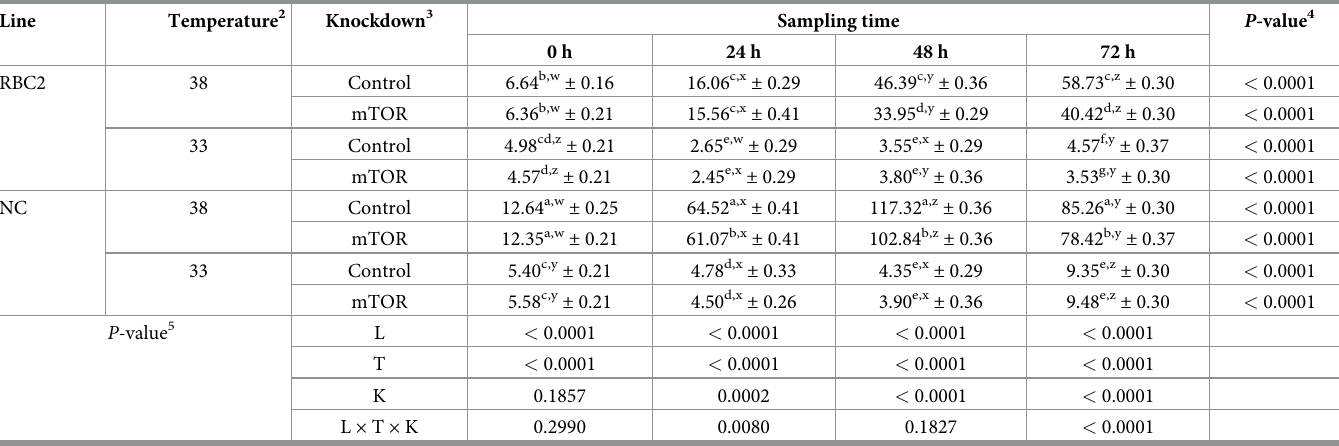
Table 7. Effect of cold stress (33˚C) and knockdown of mTOR at the beginning of differentiation on differentiation of RBC2 and NC line SCs 1 .